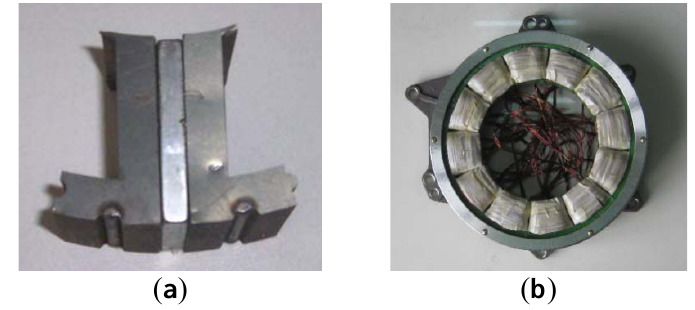
Figure 6. One module ( a ) and the assembly ( b ) of the